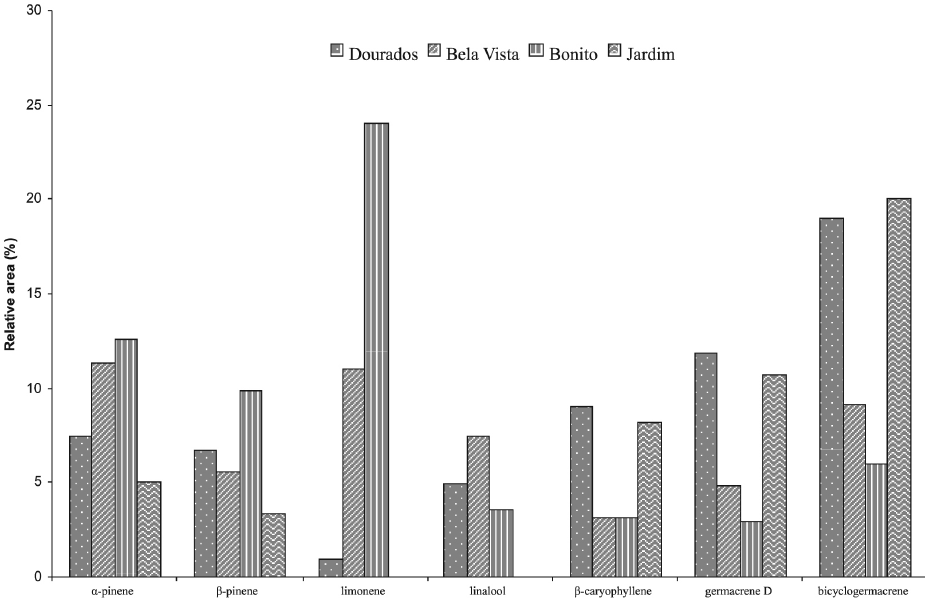
FIGURE 1 - Major compounds identified in the Campomanesia adamantium leaves collected in different localities of Mato Grosso of the Sul State, Brazil during the fruit-bearing